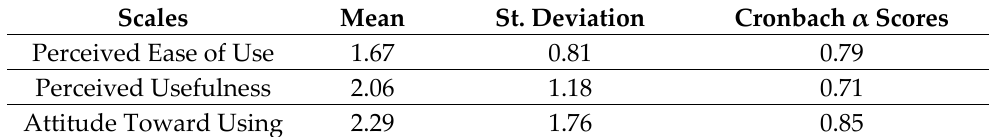
Table 1. Reliability analysis and description.